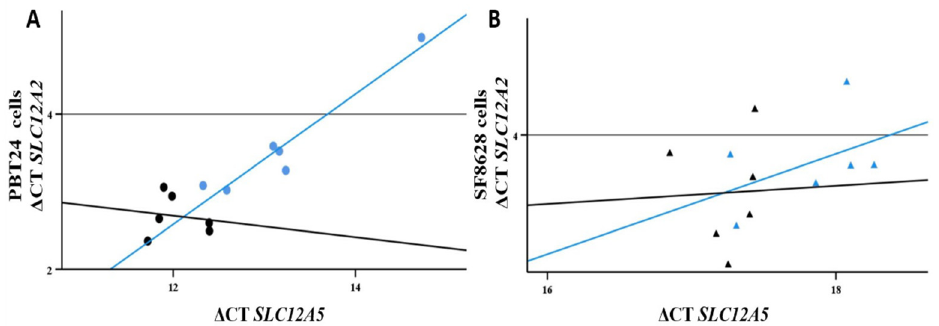
Figure 4. Correlation plots of the SLC12A2 and SLC12A5 in the PBT24 ( A ) and SF8628 ( B ) cell study groups. Blue color represents control group, black—0.5 mM VPA-treated group.